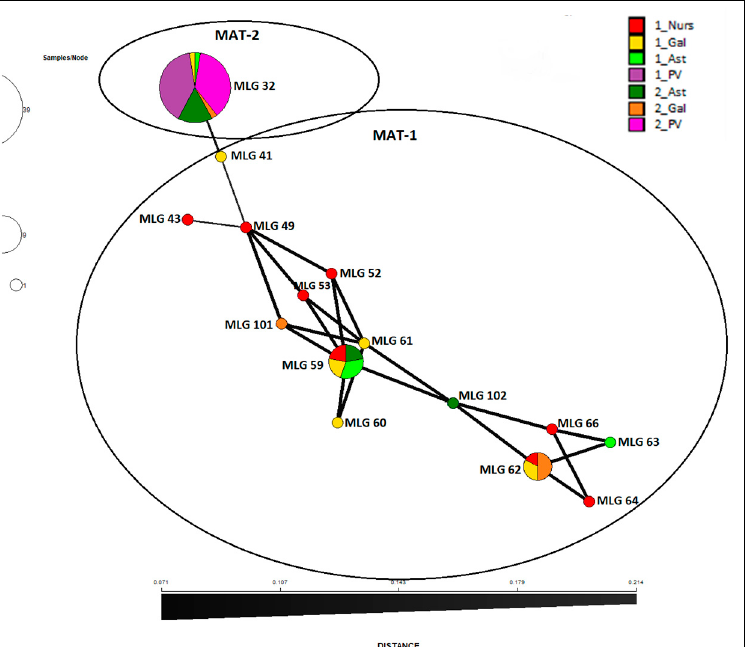
Figure 4. Minimum spanning network based on Bruvo’s genetic distance for haplotypes observed in the Spanish Fusarium circinatum population defined by survey and geographic origin. Surveys done in 2004–2011 (1_) and 2018–2021 (2_); Geographic origin: Galicia (Gal), Asturias (Ast), País Vasco (PV), and nurseries (Nurs). Table 6. Pairwise standarized Hendrick´s index (G’ st ) of genetic diversity (2005) in Fusarium circina ‐ tum (clone ‐ corrected) between Spanish populations defined in a temporal scale and by geographic origin.